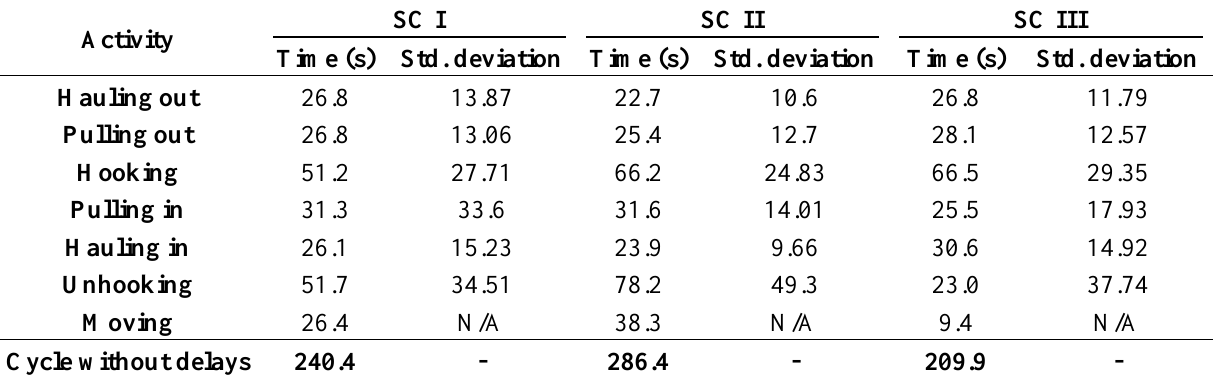
Table 4. Mean cycle times (s) and standard deviation of the individual working